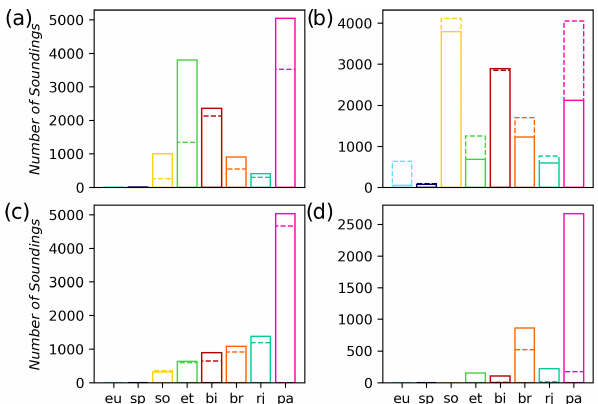
Figure 7. Same as Fig. 5 but shows the number of soundings that pass each filter at each site for the different seasons. (a) Spring (March, April, May); (b) summer (June, July, August); (c) fall (September, October, and November); (d) winter (December, Jan- uary, February). Solid bars indicate the NN filter, and dashed bars indicate the original B10